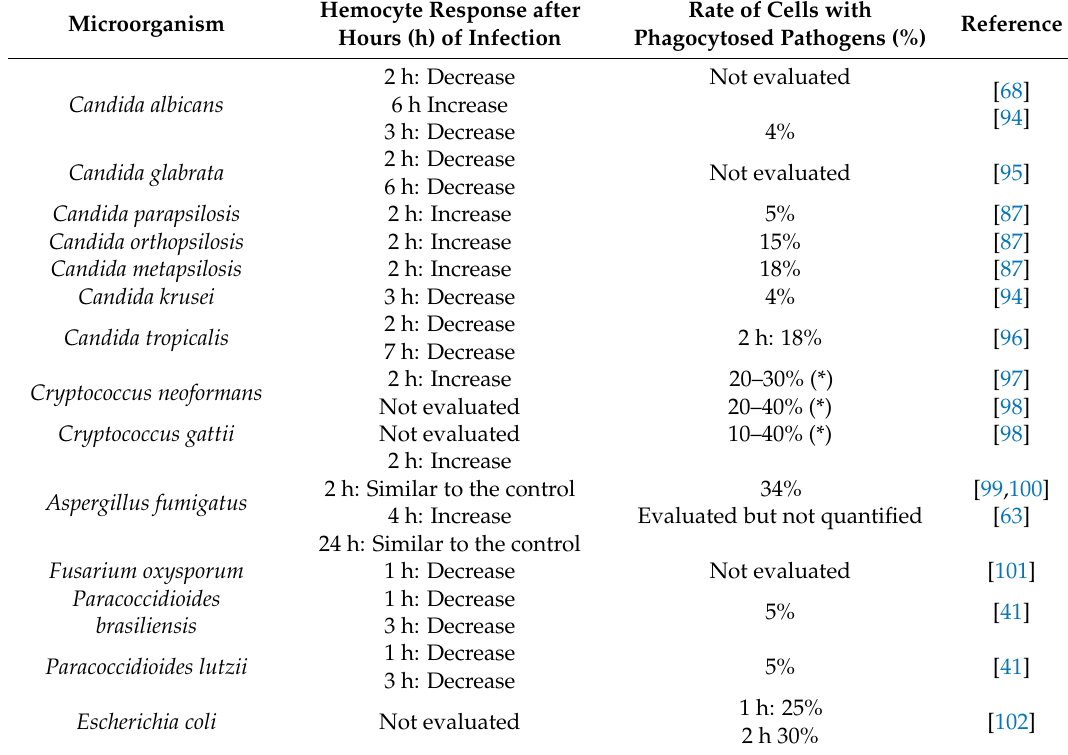
Table 2. Effect of the human pathogenic microorganisms on hemocyte concentration and phagocytosis. (*) strain-dependent phagocytosis